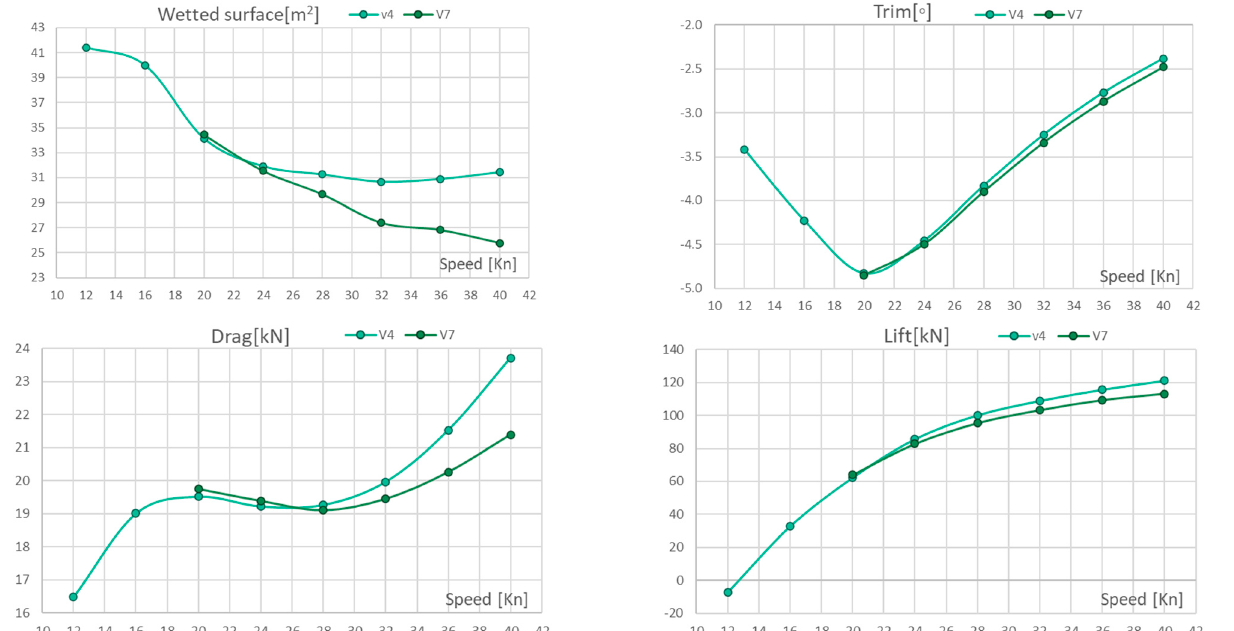
Figure 16. Variation of main computed parameters for V4 and V7. Table 16. Relative difference of global quantities: V4 vs V7. Speed